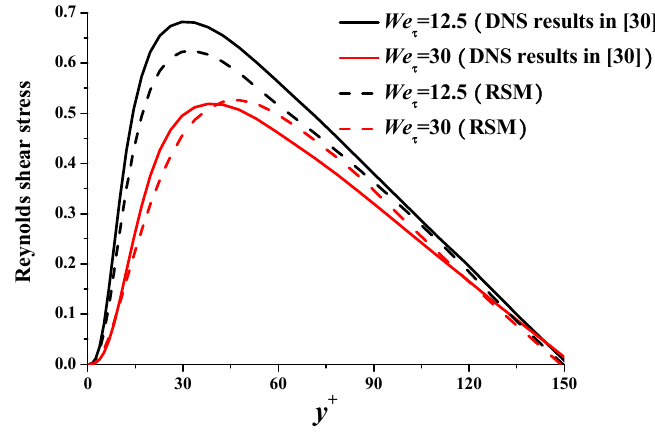
Figure 6. Mean velocity profile comparison with literature.